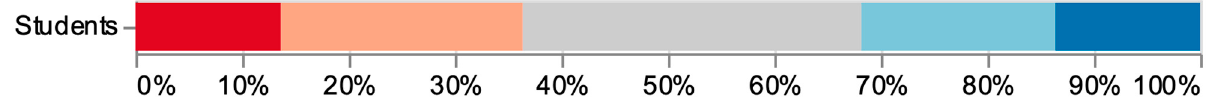
Figure 3. “I consider bivocational ministry a first choice for my ministry career” (Q19 for students). 14% strongly disagree; 23% disagree; 32% neutral; 18% agree; 14% strongly agree.